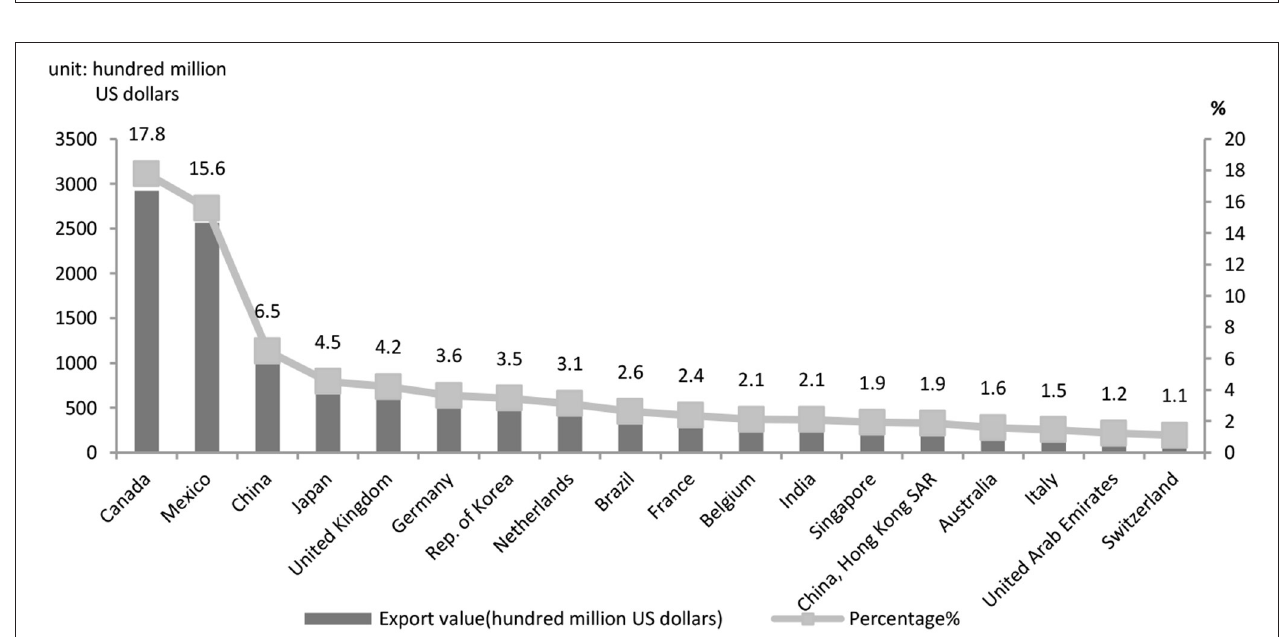
FIGURE 3 | U.S. export partner countries in 2019. Data source: WITS.